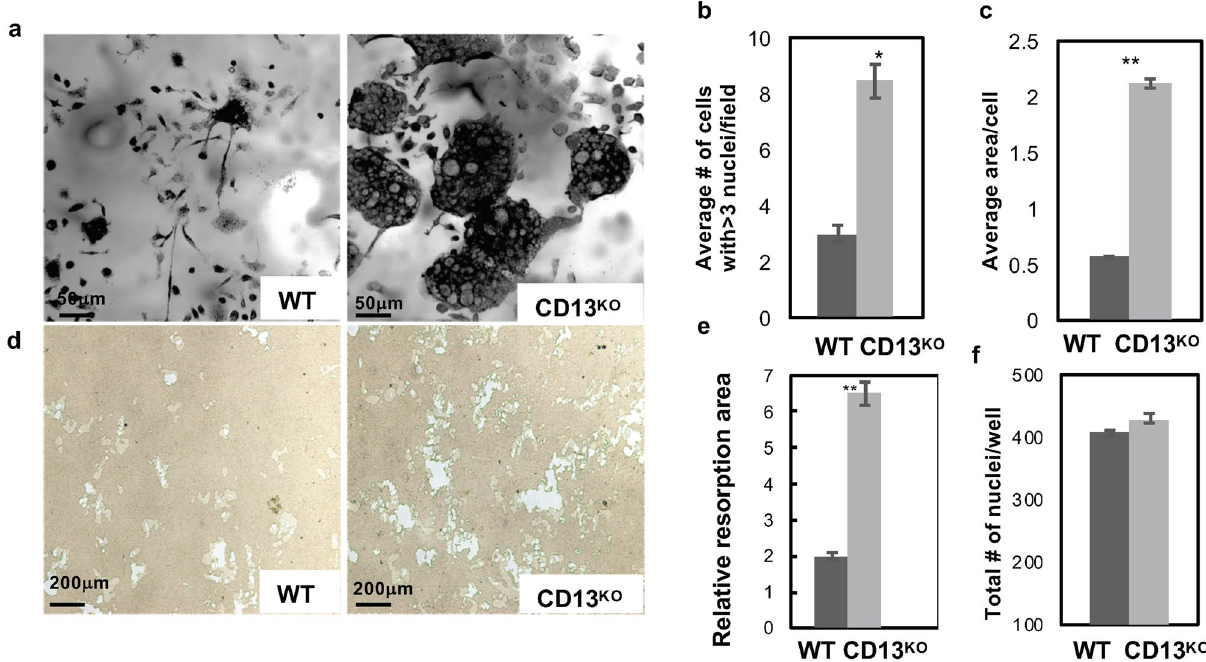
Figure 3. TRAP + multinucleated OCs are increased in the absence of CD13 in vitro. ( a ) Primary murine BM- derived osteoclast progenitor cells grown on bovine cortical slices in presence of M-CSF and RANKL led to increased OCs size and number of nuclei/OC in CD13 KO cells compared to WT at d5. ( b ) Average # of cells with > 3 nuclei/field and ( c ) Average cell area per OCs in CD13 KO are significantly larger than the WT cells. ( d ) Area of resorption is significantly higher in CD13 KO than WT OCs grown on osteoplates for d10 by phase contrast imaging. Osteoclasts on cortical slices and cluster of pits formed were imaged using a light microscope (Olympus Scientific), using Olympus cellSens Dimension V0118 software (Olympus Scientific) (https:// www. olymp us- lifes cience. com/ en/ softw are/ cells ens/) and the area of resorption was quantified by Image J (https:// imagej. nih. gov/ ij/) ( e ) and total number of nuclei/well of both genotypes ( f ) are shown. Scale bars-( a ) 50 µm; ( d )